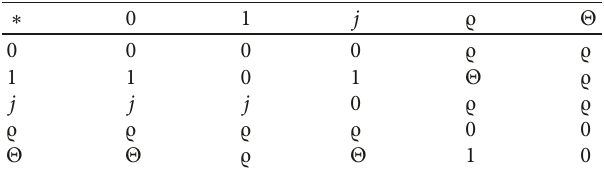
Table 3: Cayley table of the binary operation ∗ .